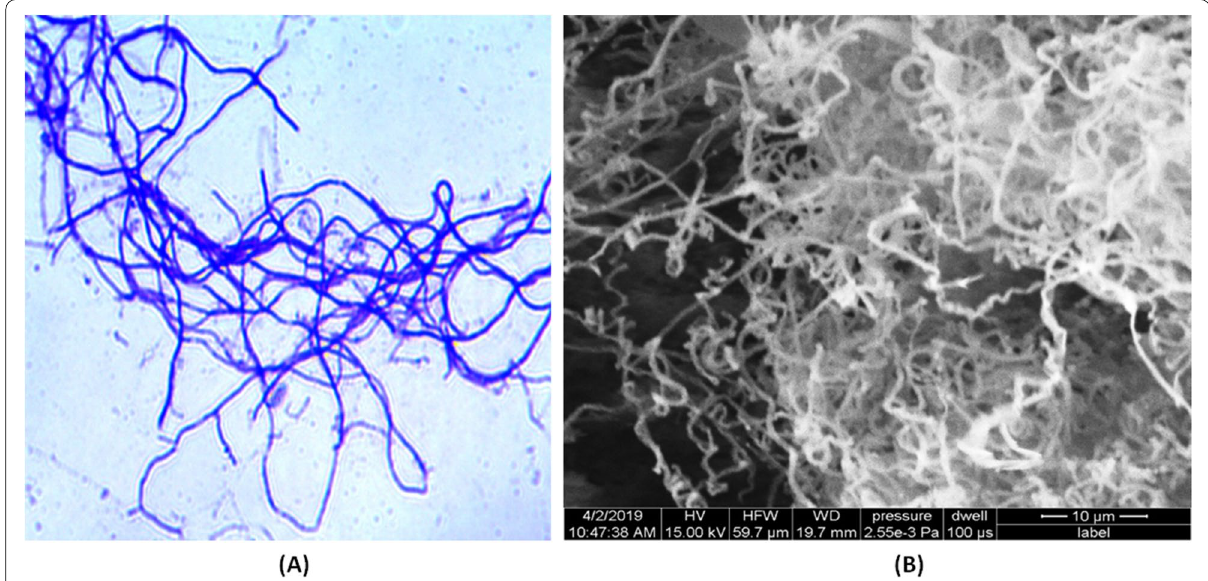
Fig. 2 Photomicrograph ( 1000) of mycelia ( A ) and scanning electron micrograph of spores ( B ) of Streptomyces isolate JB140 ×